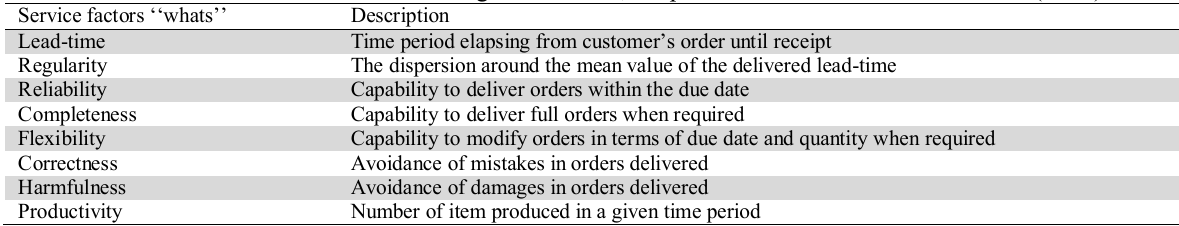
List of viable factors for the evaluation of logistics service, adapted from Franceschini and Rafele (2000) Service factors